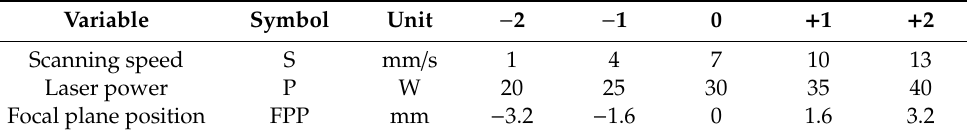
Table 1. Three levels of cutting parameters.